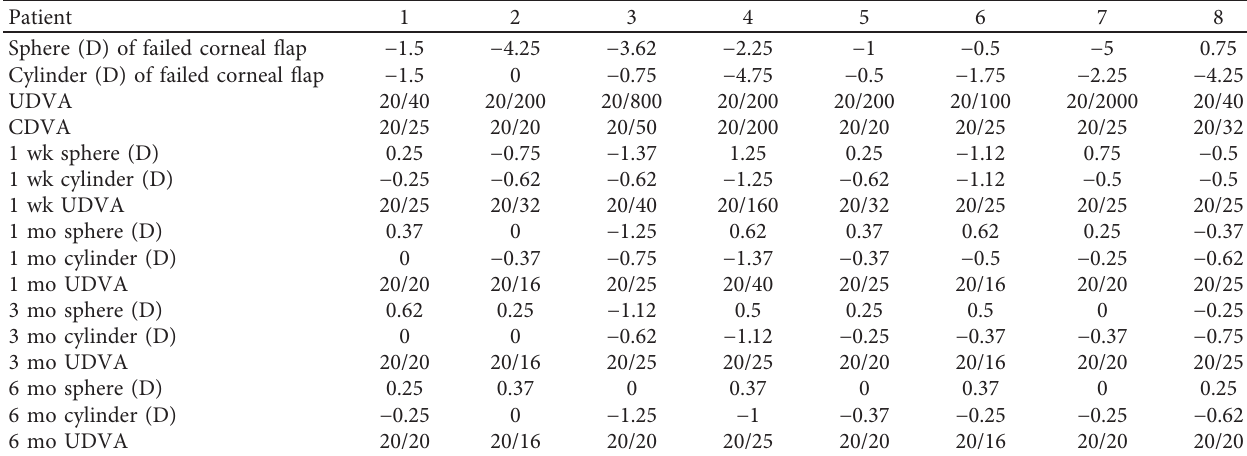
Table 2: Preoperative and postoperative diopter measurements of patients receiving